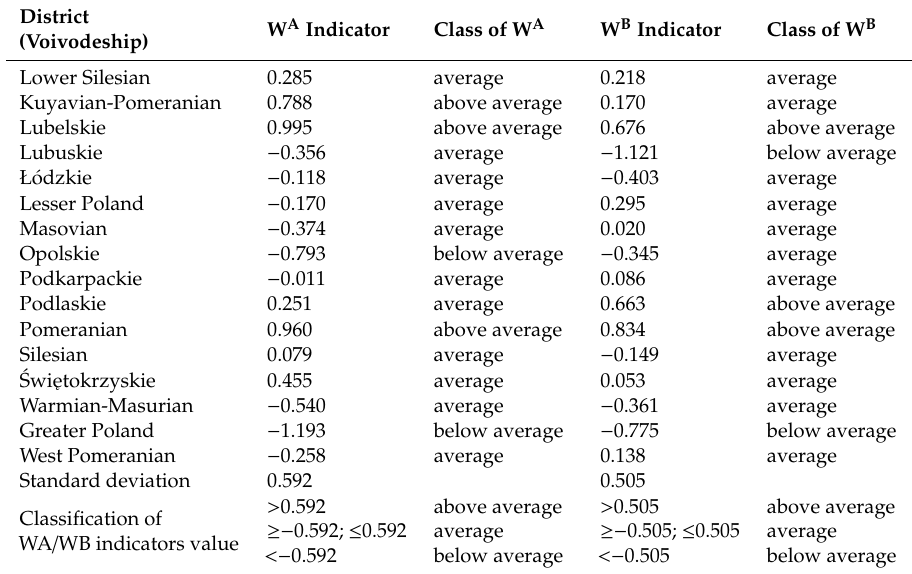
Table 4. Values and classification of Perkal’s indicators (W A and W B